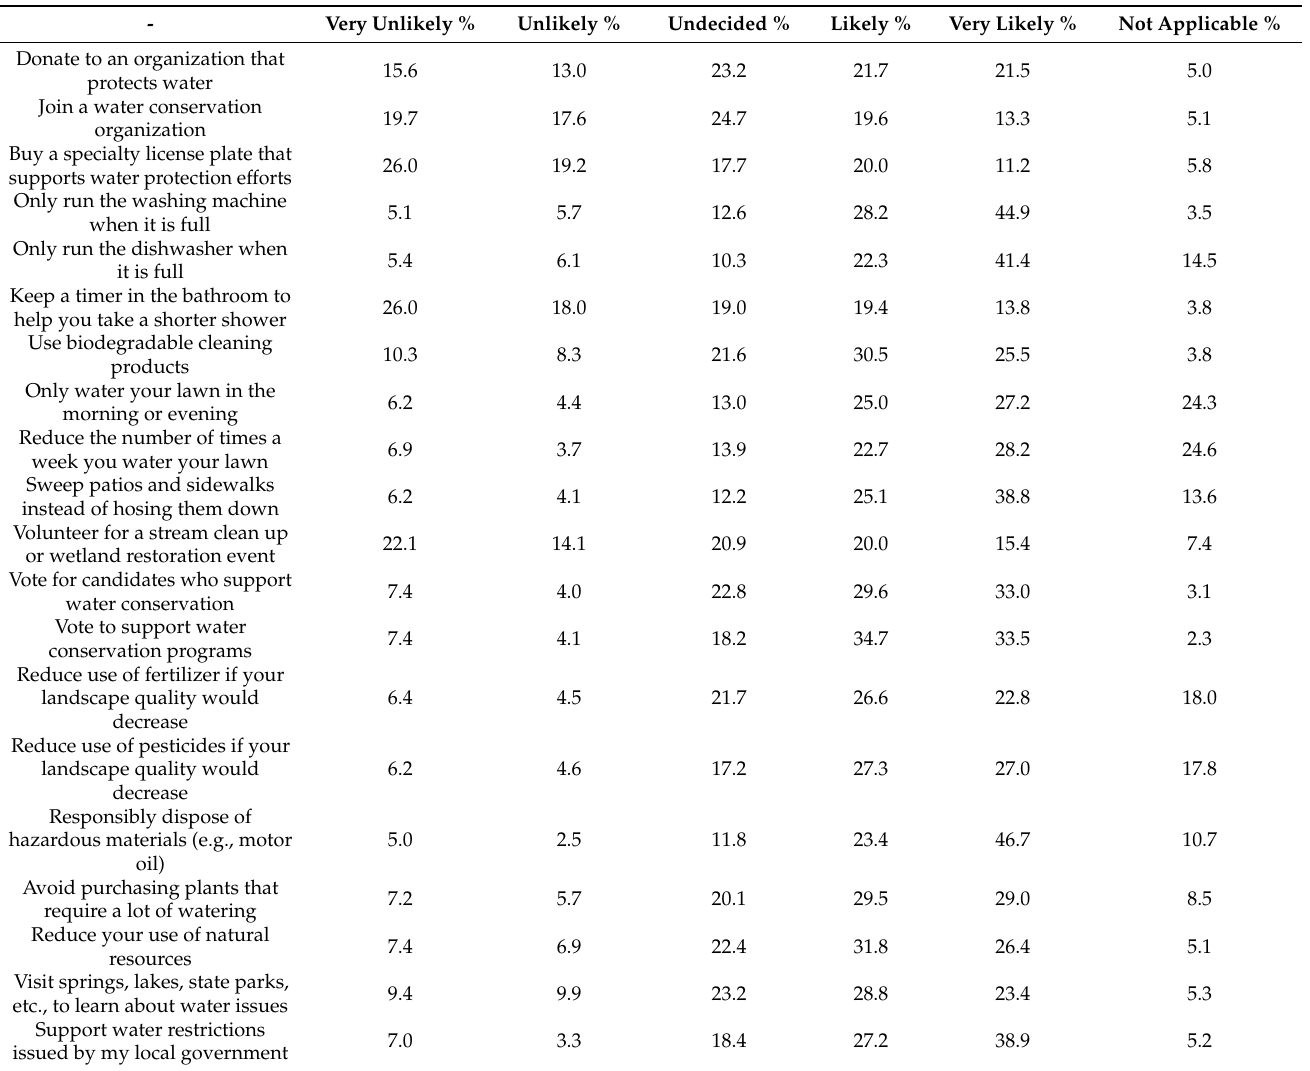
Table 4. Respondents’ self-reported intent to engage in water conservation behaviors (N =